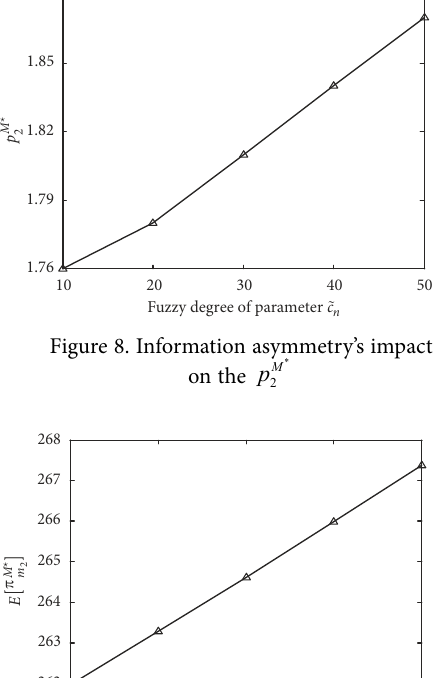
Figure 11. Information asymmetry’s impact on